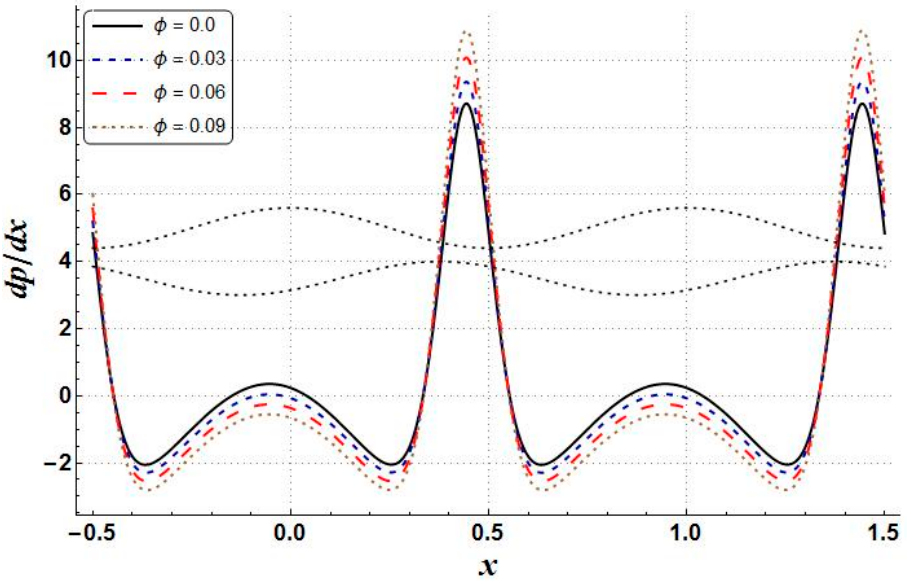
through changing values of φ , where γ = π dx